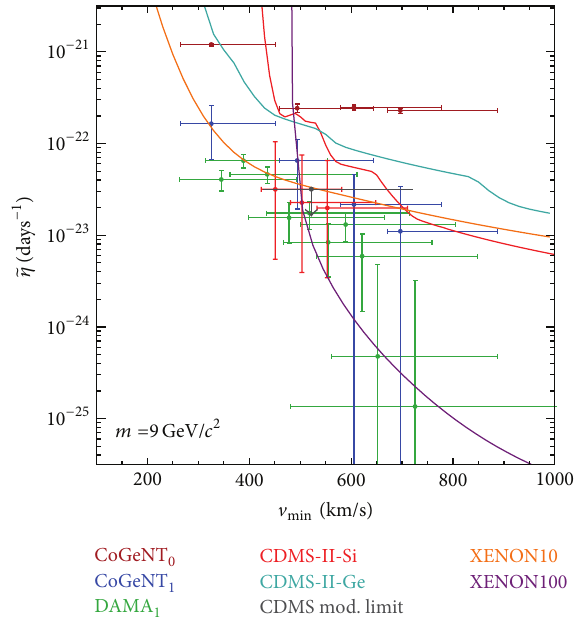
Figure 5: As in Figure 4 but for 𝑚 = 9 GeV/ 𝑐 2 . All data points have moved to smaller V min values as expected.